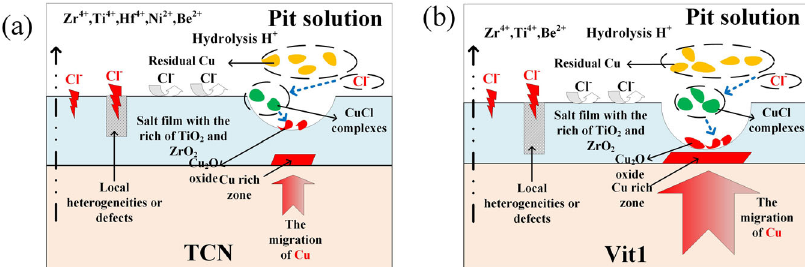
Fig. 13 Pitting mechanisms for different alloy samples during potentiodynamic polarization in 3.5 wt. % NaCl. a TCN and b